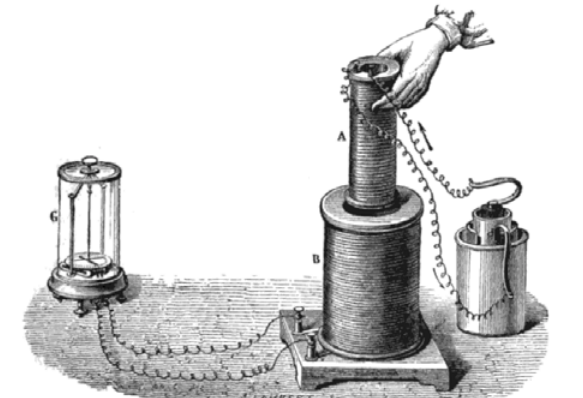
Figure 17. Scheme of the experiment of electromagnetic induction by Faraday, October 17th, 1831. By vertically moving the smallest coil within the larger one the magnetic field flux concatenated to the latter is varied and a passage of current in it is observed. This is a confirmation of the dynamic nature of the phenomenon of the electromagnetic induction (1892)